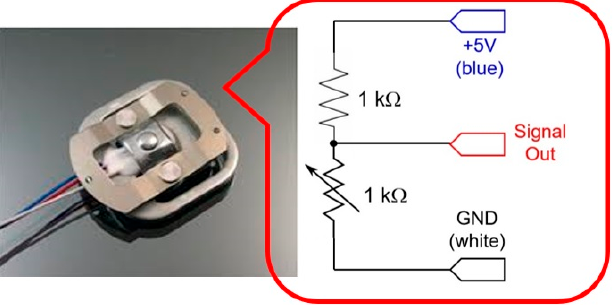
Figure 1. Picture of a load-cell and its equivalent circuit.